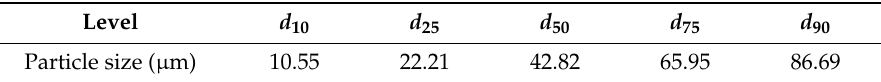
Table 2. Particle size representative value.